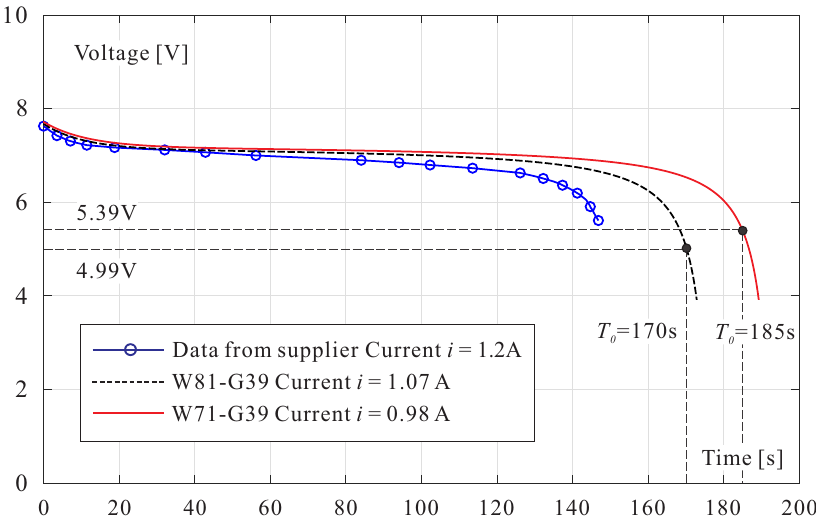
Figure 11. L = 22.8 gr. Discharge curve of two batteries B2 in series for a discharge rate of 1.07 A ( T 0 = 170 s) and 0.98 A ( T 0 = 185 s).